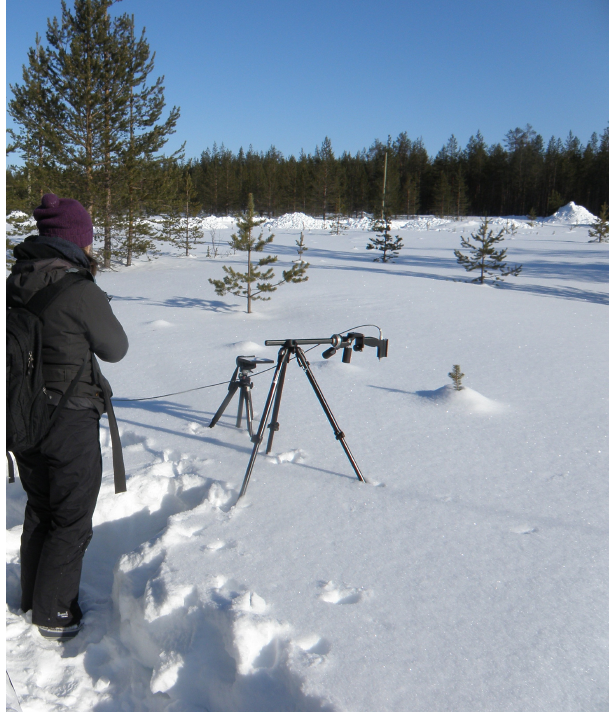
Figure 7. Measurement setup for field measurements with the ASD FieldSpec Pro JR spectroradiometer. During the measurement, the operator stepped away and squatted to minimize the effect on the